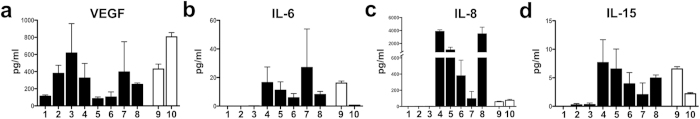
Cytokine profiling of primary tumour tissue and monolayer tumour cells in vitro.(a–d) Cytokine levels in monolayer cell supernatants and tumour tissue lysates were measured with multiplex cytokine assays. Bars and error bars represent mean and SEM of three separate experiments. 1, AA-LU 74 (24 h); 2, AA-LU 74 (48 h); 3, AA-LU 74 (72 h); 4, AEP-LU 149 (48 h); 5, AEP-LU 158 (48 h); 6, MB-LU 69 (48 h); 7, MB-LU 70 (48 h); 8, MB-LU 140 (48 h); 9, AEP-LU 158 (tissue); 10, MB-LU 140 (tissue).